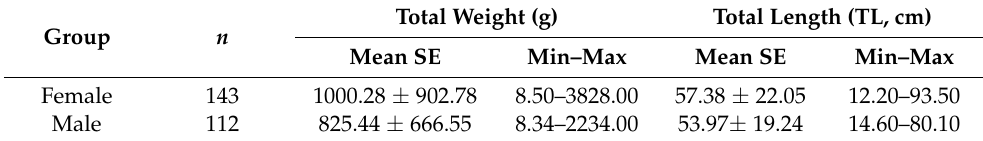
Table 1. Descriptive statistics for Dipturus oxyrinchus inhabiting the Northeastern Mediterranean Sea.